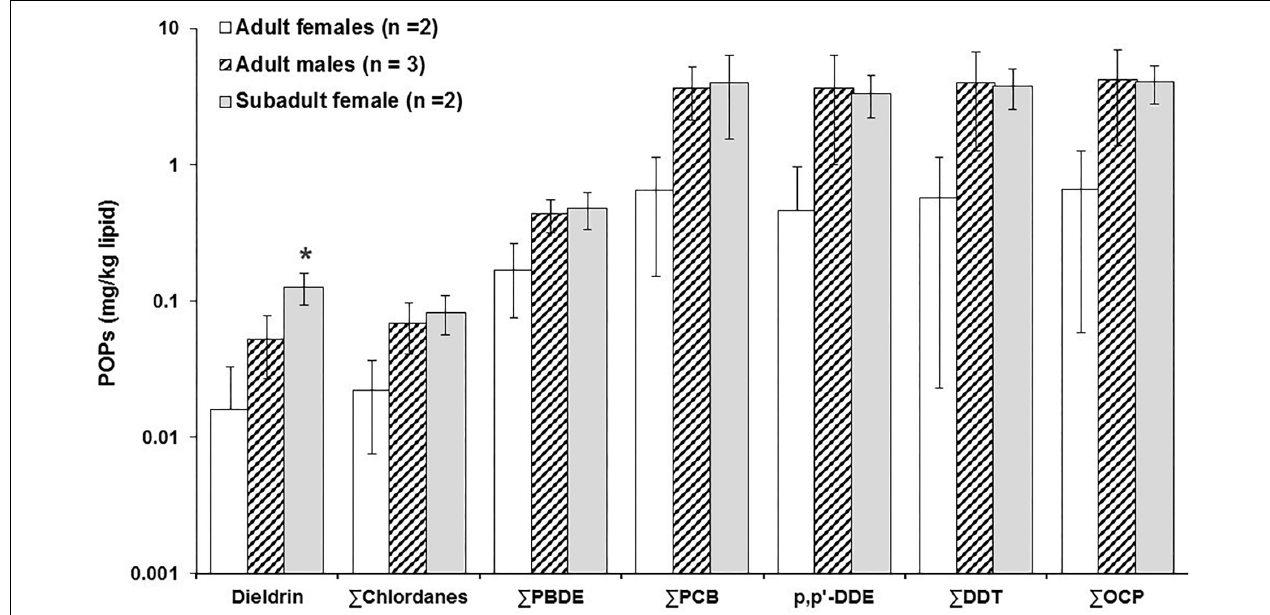
FIGURE 2 | Mean ± SD of concentrations (mg/kg lipid weight) of dieldrin, (cid:54) Chlordanes, (cid:54) PBDE (cid:54) PCB, p,p (cid:48) -DDE, (cid:54) DDT, and total organochlorine pesticides ( (cid:54) OCP) in blubber of adult (males and females) and subadult (females) bottlenose dolphins sampled in May 2018 in the El Morro Mangrove Wildlife Refuge (REVISEM), and Posorja Port, Gulf of Guayaquil, Ecuador. No significant differences were found between adult age categories of males and females and subadult females, except for Dieldrin, being significantly higher in subadult females, as indicated by the asterisk (*).